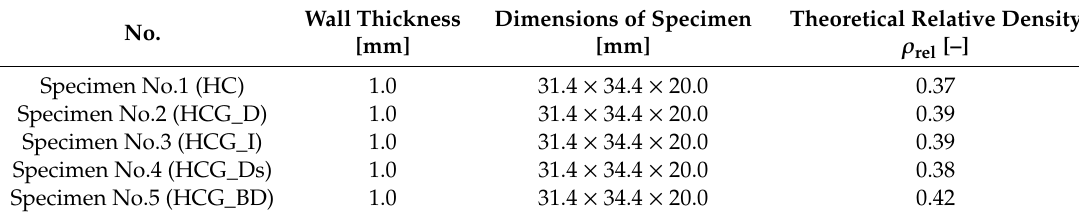
Table 2. Mechanical properties of TPU 95 Polyflex material available on the producer